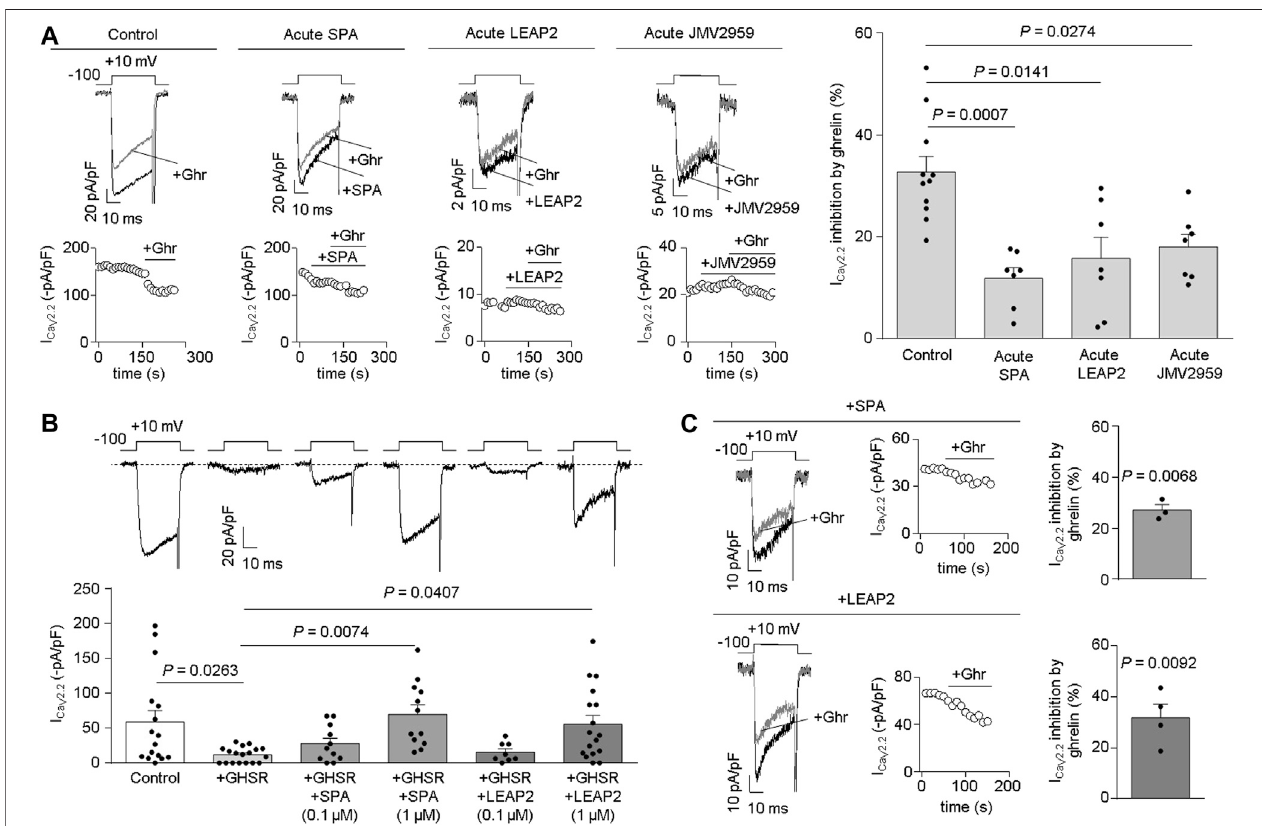
FIGURE 1 | Acute LEAP2 reduces ghrelin-dependent and -independent effects of GHSR on Ca V 2.2 currents. (A) Representative traces and time courses (left) of Ca V 2.2current(I CaV2.2 )fromHEK293TcellscotransfectedwithCa V 2.2,Ca V β 3 ,Ca V α 2 δ 1 andGHSRin0.1GHSR:Ca V 2.2molarratioincontrolconditionandghrelin(+Ghr) application (Control, n (cid:2) 11); or consecutive SPA and ghrelin application (Acute SPA, n (cid:2) 7); or consecutive LEAP2 and ghrelin application (Acute LEAP2, n (cid:2) 7); or consecutive JMV2959 and ghrelin application (Acute JMV2959, n (cid:2) 7). Bars (right) represent averaged I CaV2.2 inhibition by 0.5 µM ghrelin application for each condition. Statistical signi fi cance wasevaluated byKruskal-Wallis and Dunn ’ s post-test (vs. Control). (B) Representative traces (top left) ofCa V 2.2 current (I CaV2.2 ) from HEK293T cells cotransfected with Ca V 2.2, Ca V β 3 , Ca V α 2 δ 1 and, empty pcDNA3.1 (Control, n (cid:2) 16) or GHSR in 0.6 GHSR:Ca V 2.2 molar ratio (+GHSR, n (cid:2) 18), pre- incubated or not with 0.1 µM or 1 µM of SPA [+GHSR +SPA (0.1 µM), n (cid:2) 11; +GHSR +SPA (1 µM), n (cid:2) 12], or 0.1 µM or 1 µM of LEAP2 [+GHSR +LEAP2 (0.1 µM), n (cid:2) 8;+GHSR+ LEAP2(1 µM), n (cid:2) 17] during20 h. Bars (bottom left) represent averaged I CaV2.2 levelsforeach condition.Statisticalsigni fi cancewasevaluatedbyOne Way ANOVA and Tukey ’ spost-test. (C) Representative traces and timecourses ofI CaV2.2 from HEK293T cellscotransfected with Ca V 2.2, Ca V β 3 , Ca V α 2 δ 1 and GHSRin 0.6 GHSR:Ca V 2.2 molar ratio pre-incubated with 1 µM of SPA (top right) or with 1 µM of LEAP2 (bottom right) during 20 h. Ghrelin was applied after washing SPA (SPA, n (cid:2) 3)orLEAP2(LEAP2, n (cid:2) 4).BarsrepresentaveragedI CaV2.2 inhibitionby0.5 µMghrelinapplicationforeachcondition.Statisticalsigni fi